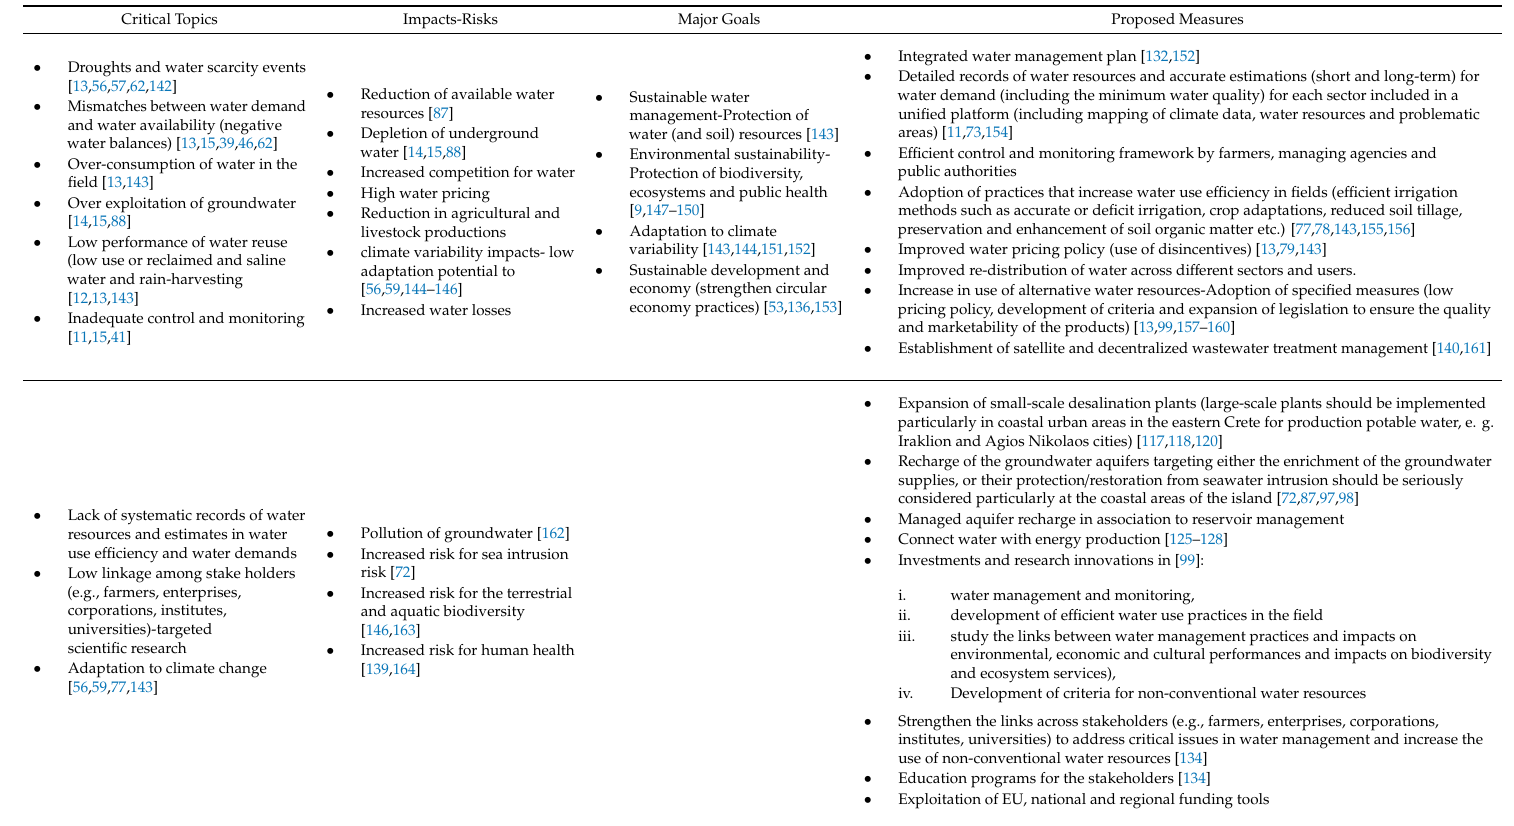
Table A1. Critical topics, impacts-risks, and proposed measures and funding sources for sustainable water management in